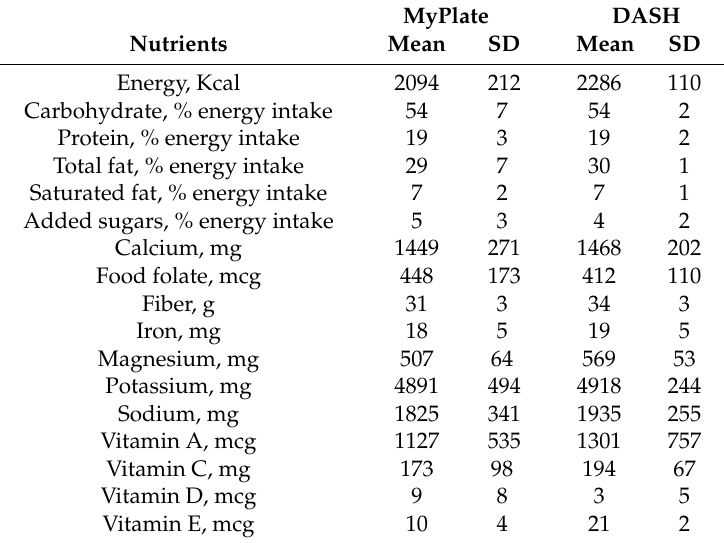
Table A1. Nutrient composition of MyPlate and DASH menu